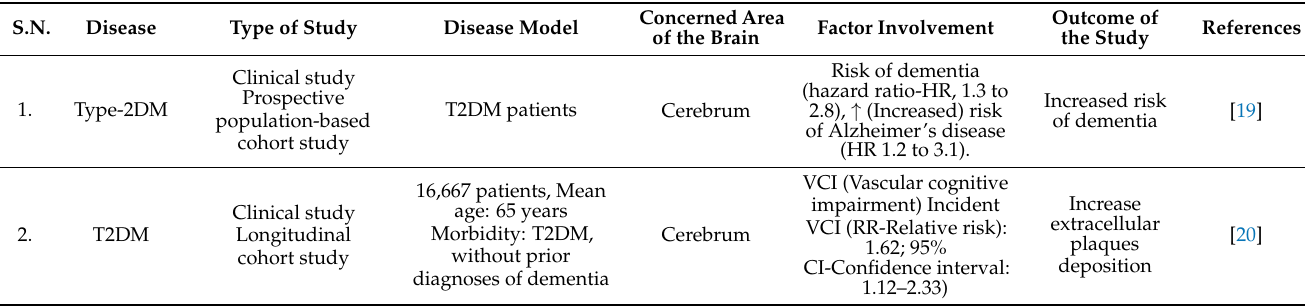
Table 1. The common occurrence of neurological complications in insulin-resistant